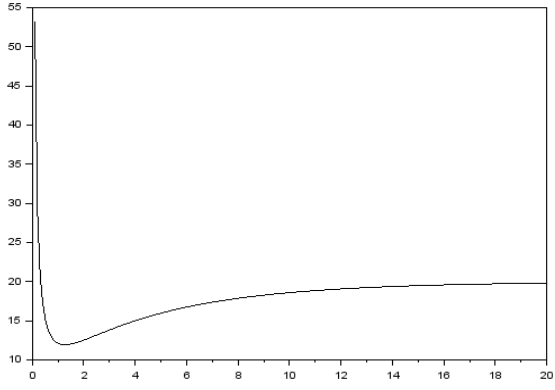
Figure 6. The shape of c a (T) for p  =0.4,  =0.2, C I =5, C R =15, C D